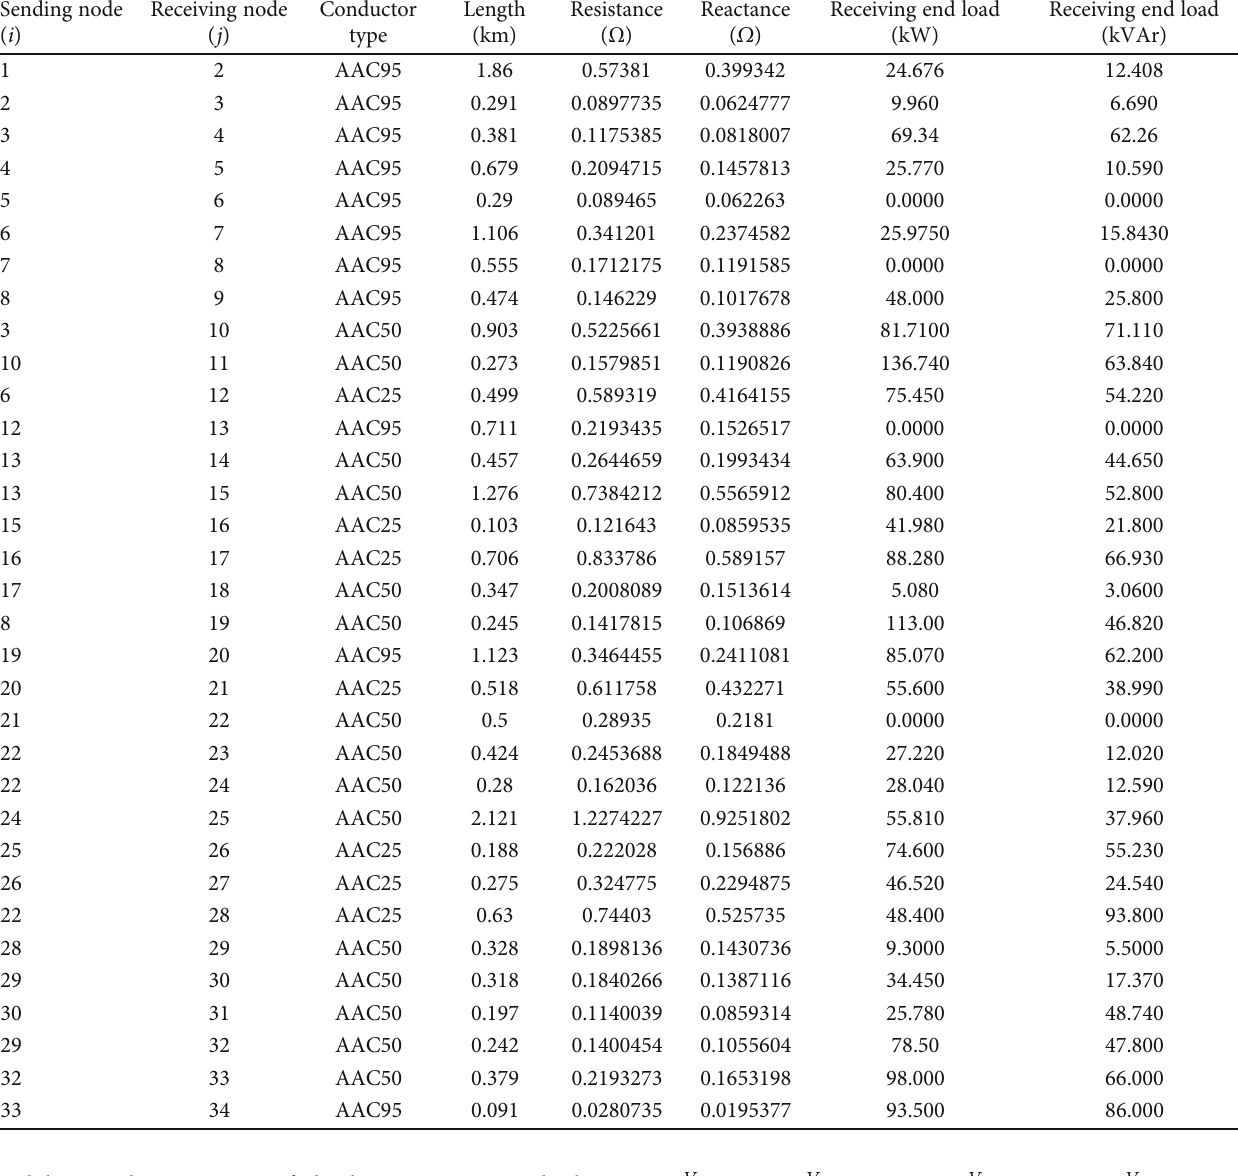
Table 2: Line and load data for the BATA feeder.